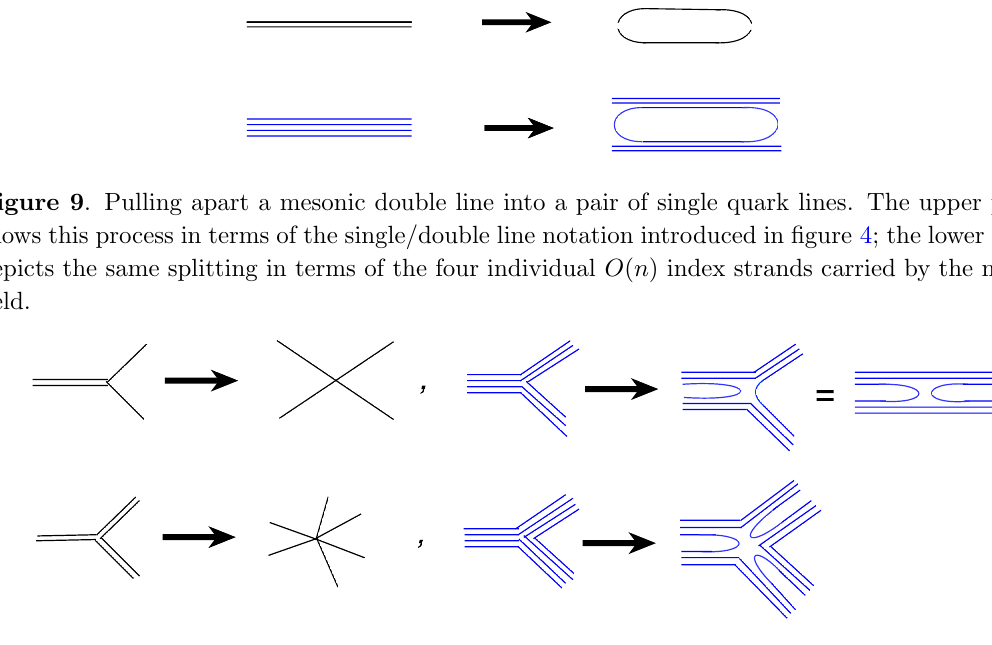
Figure 10 . Modi(cid:12)cation of the vertices. The top left panel shows the resolution of the (cid:25) vertex into a quartic vertex of single lines, and the bottom left panel shows the resolution of the (cid:31)(cid:31)(cid:31) vertex into a 6-valent vertex. The right panels show the same procedure in terms of the individual vector index